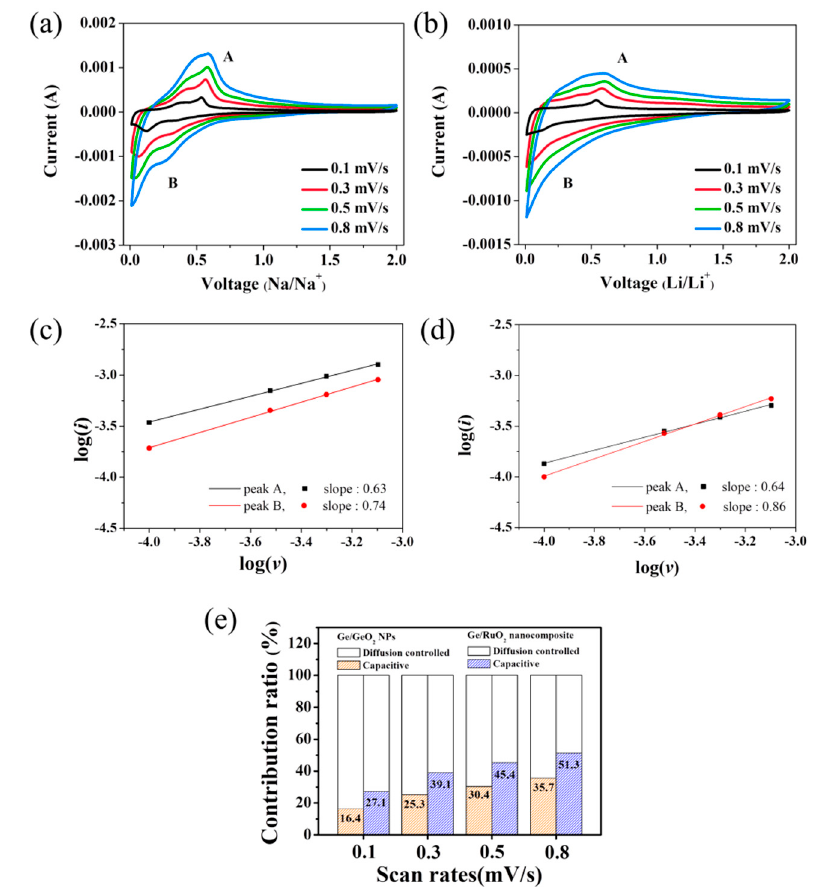
Figure 8. Contribution of diffusion-controlled and pseudocapacitive charge-storage processes in functioning cells at a scan rate of 0.8 mV s 1 for ( a ) Ge/GeO 2 NPs and ( b ) the Ge/RuO 2 nanocomposite. log( i ) versus log( v ) plot of ( c ) Ge/GeO 2 NPs and ( d ) Ge/RuO 2 nanocomposite (The slopes were calculated from the peak A and B in Figure 8a,b). ( e ) Change in the contribution ratio of diffusion- controlled and pseudocapacitive charge-storage processes at varying scan rates.